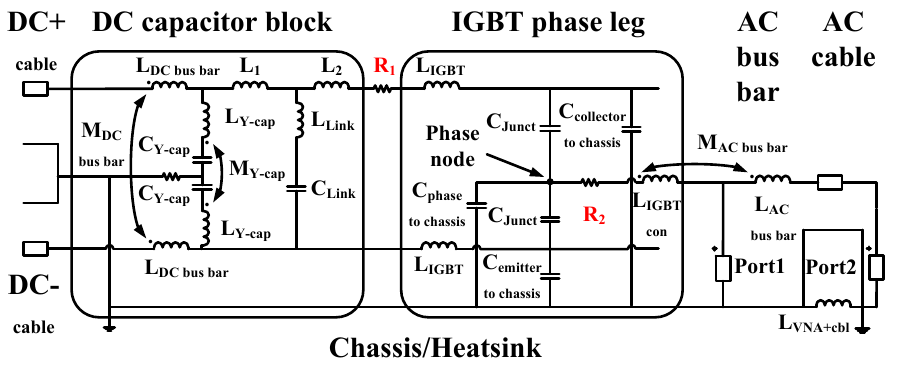
Figure 3. Two ‐ port net PSPICE equivalent circuit model of the system. Port 1: between the IGBT phase node and chassis; Port 2: between the inner and outer conductor at the end of the AC cable.